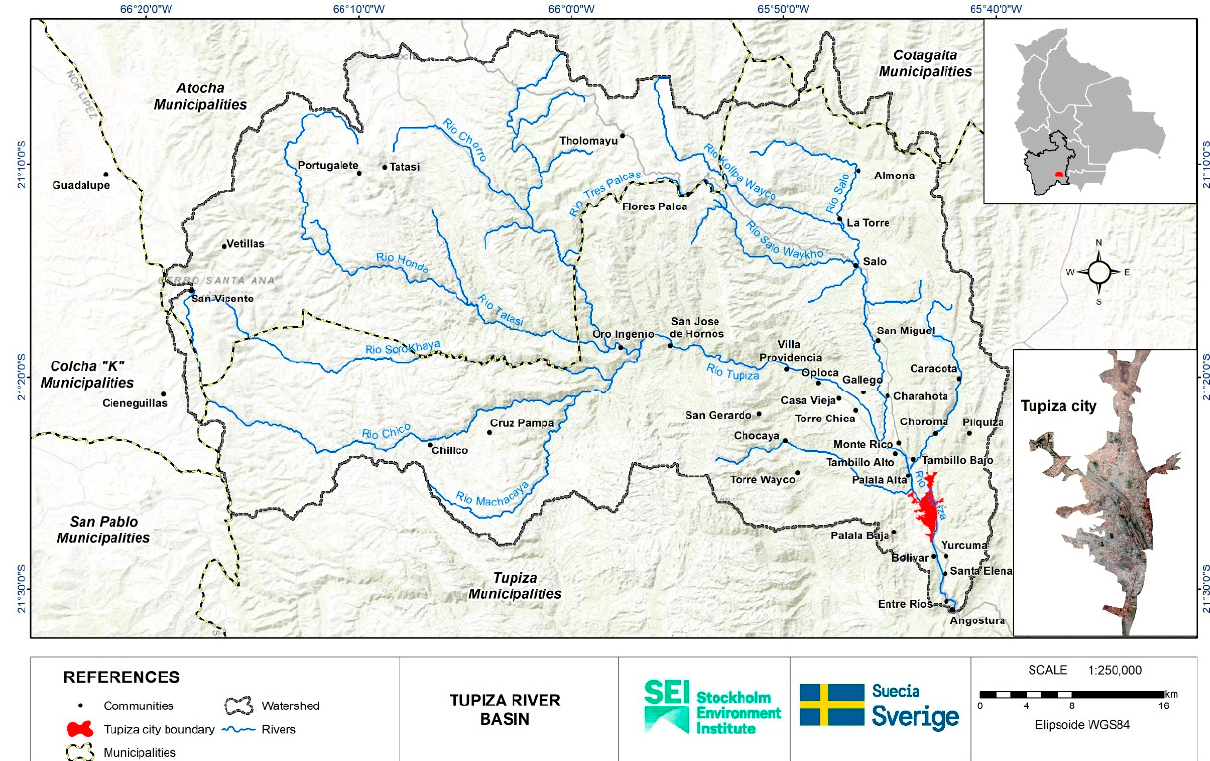
Figure 1. Communities and urban areas of the Tupiza river basin.